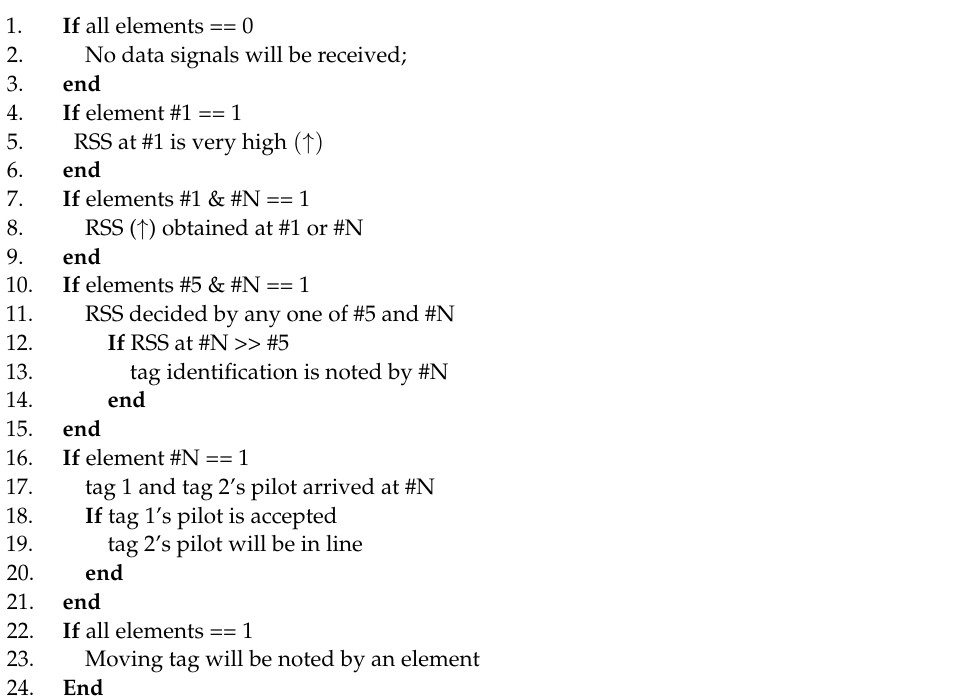
Algorithm 1: Tag’s Localization Beam Scanning